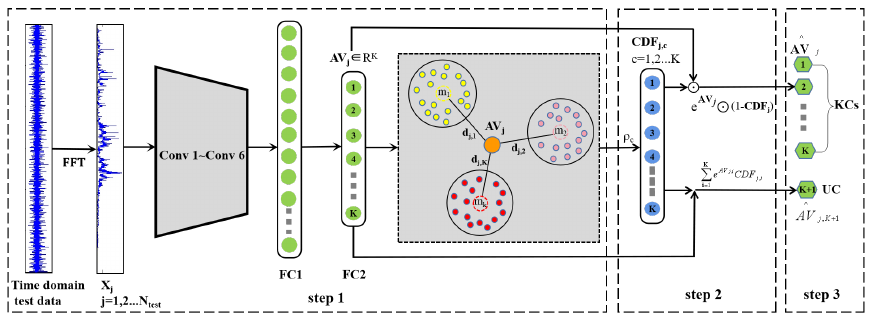
Figure 5. The proposed OSA fault diagnosis method of the testing phase, which is divided into three steps by the dashed